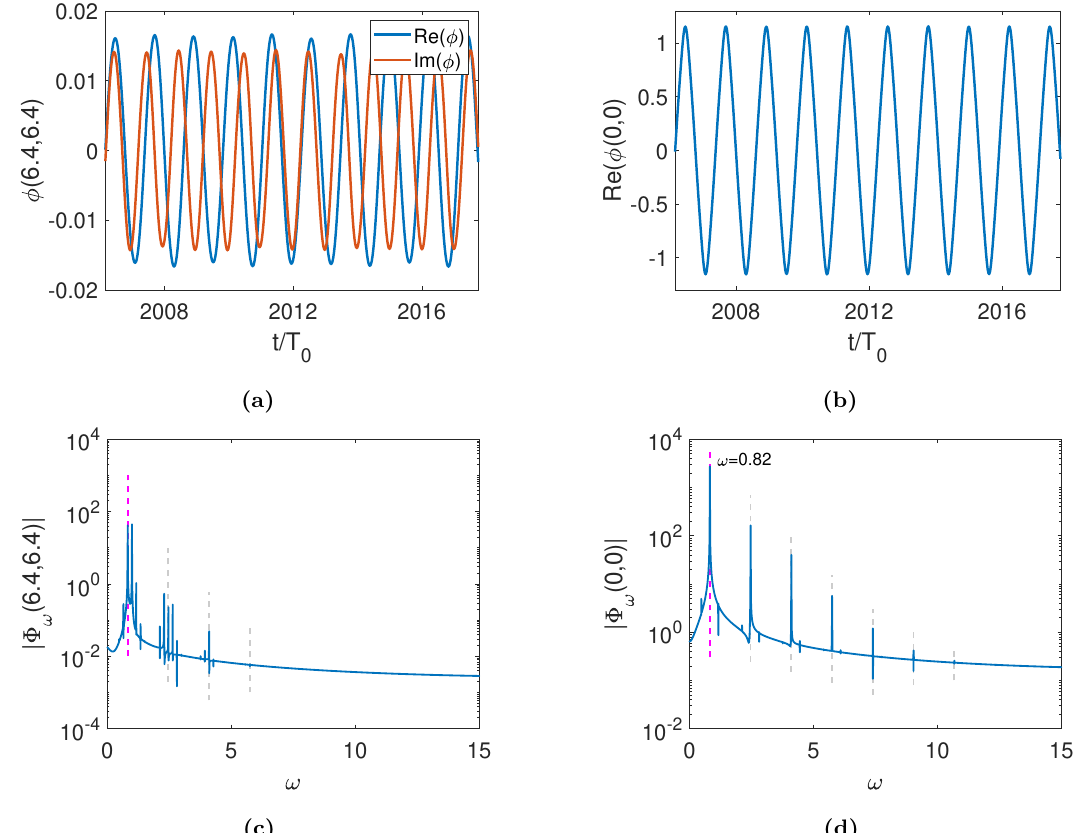
Figure 12. Field values at ( x = 6 . 4 , y = 6 . 4) and ( x = 0 , y = 0) and their temporal Fourier transforms in the CSQ stage. Φ ( x, y ) is the Fourier transform of φ ( t, x, y ) from t = 1800 T ω 3000 T . Dashed lines in the two bottom plots show the odd multiples of ω = 0 . 82 , which match 0 the spectral